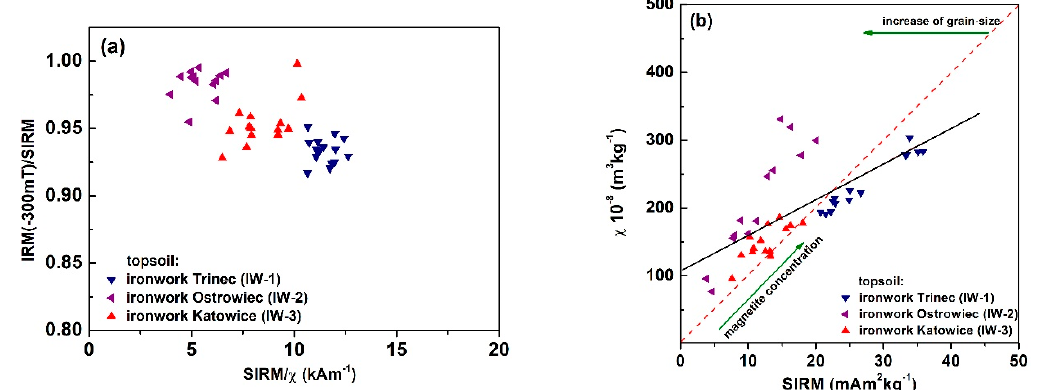
Figure 13. S-ratio versus SIRM / χ ratio ( a ) and χ versus SIRM ( b ) for topsoil samples collected nearby the ironworks. In figure ( b ), the solid line was fitted to the topsoil samples for all the areas affected by ironworks. The diagonal line (dashed) reflecting the concentration of magnetite and grain size distribution was constructed according to Thompson and Oldfield [50].